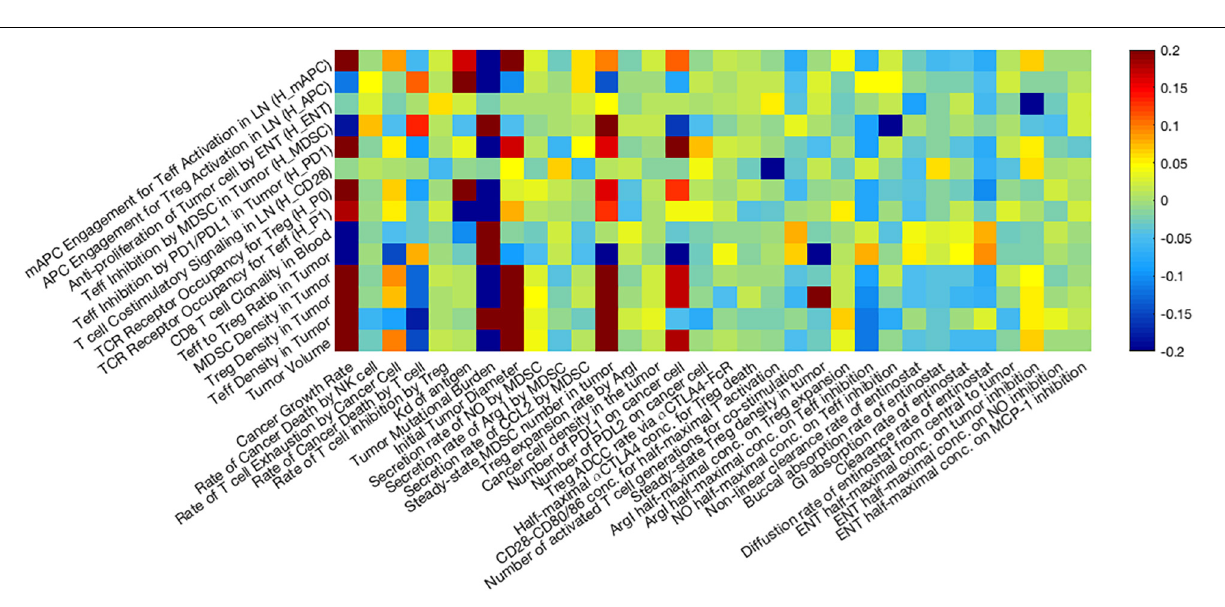
FIGURE 7 | Global uncertainty and sensitivity analysis. Thirty two parameters are assigned using Latin Hypercube Sampling (LHS) based on our estimated distribution, and the Partial Rank Correlation Coefficient (PRCC) between selected post-treatment observations and input parameters are presented as a heatmap. Among 32 parameters, tumor growth rate, T cell exhaustion, cancer killing rate by T cells, TMB, initial tumor diameter, steady-state MDSC density, PD-L1 expression on cancer cells, and inhibitory effect of Arg-I on T cells are significantly correlated with post-treatment tumor